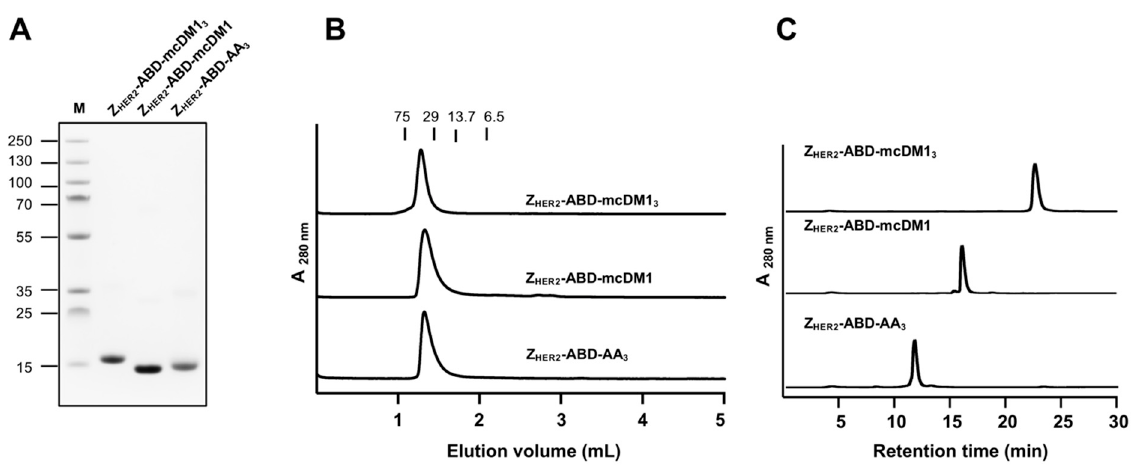
Figure 2. Biochemical characterization of the conjugates. ( A ) Analysis of the anti-HER2 affibody molecules equipped with a single mcDM1 drug molecule and the non-toxic control by sodium dodecyl sulfate polyacrylamide gel electrophoresis (SDS-PAGE) under reducing conditions. The numbers to the left indicate the molecular weights of the marker proteins in lane M (kDa). ( B ) Analysis of the conjugates by size-exclusion chromatography under native conditions. The numbers above the chromatograms indicate the elution volumes of protein standards with different molecular weights (kDa). ( C ) Analysis of the conjugates by reversed-phase high-performance liquid chromatography (RP-HPLC). The conjugates were eluted with a 30 min linear gradient from 30 to 60% acetonitrile in water supplemented with 0.1% trifluoroacetic acid (TFA).